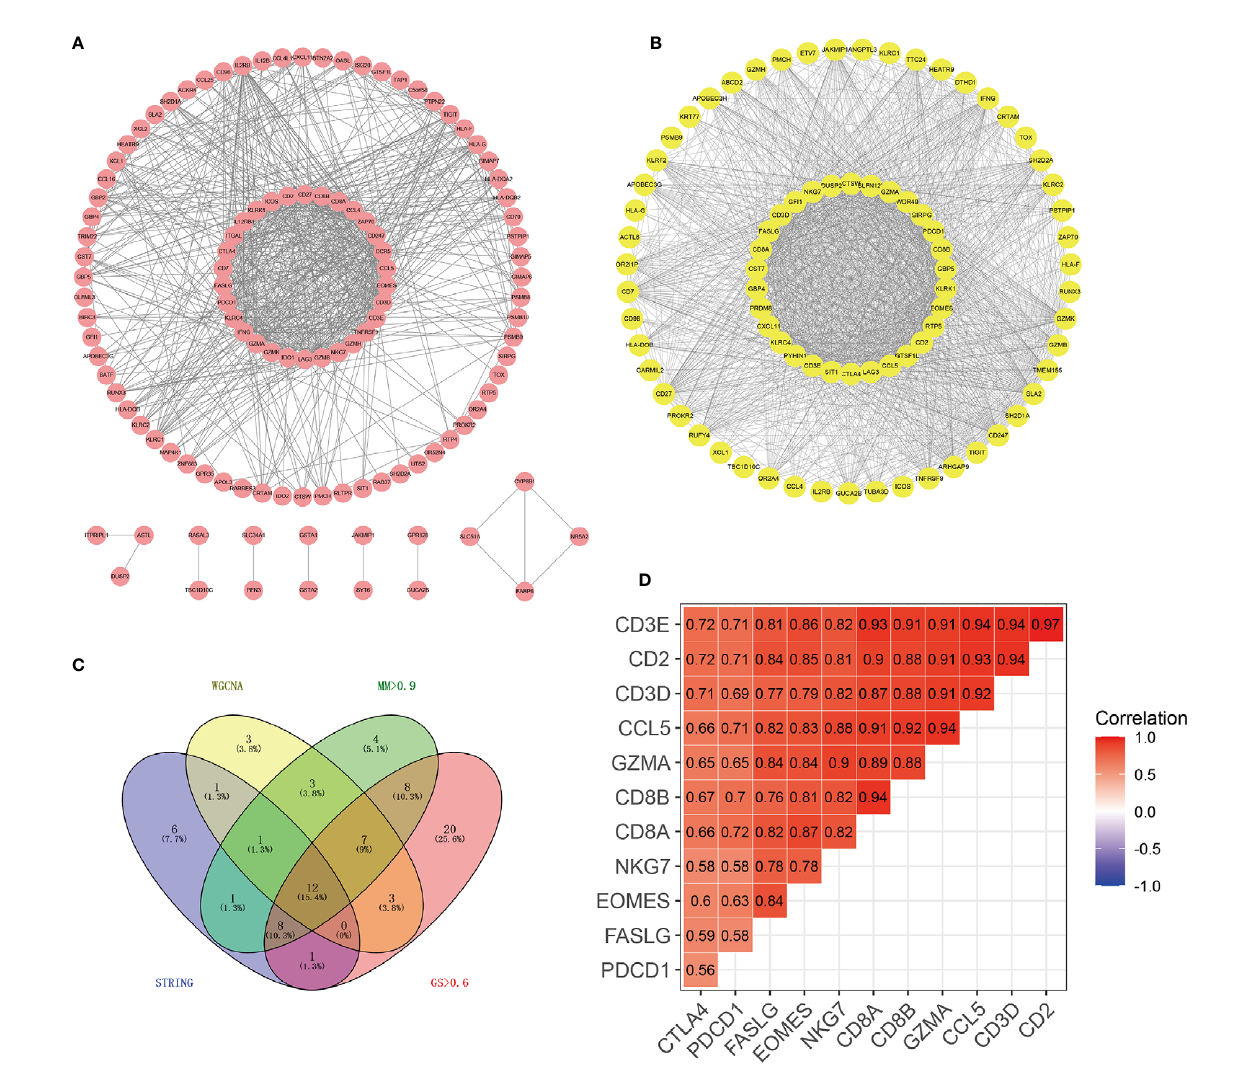
FIGURE 2 | Identi fi cation of 12 hub genes by PPI and WGCNA co-expression networks. (A) PPI network of genes in the purple module. Using the MCC algorithm, the top 30 genes in the PPI network were the hub genes of the PPI network. (B) Weighted co-expression network of nodes with weights > 0.4 between two nodes in the purple module. The top 30 genes in the network scored by the MCC algorithm were the hub genes of the co-expression network. (C) The Wayne diagram showed the common hub genes in the PPI network and the co-expression network. (D) The correlation heat map showed the correlation coef fi cients among 12 hub